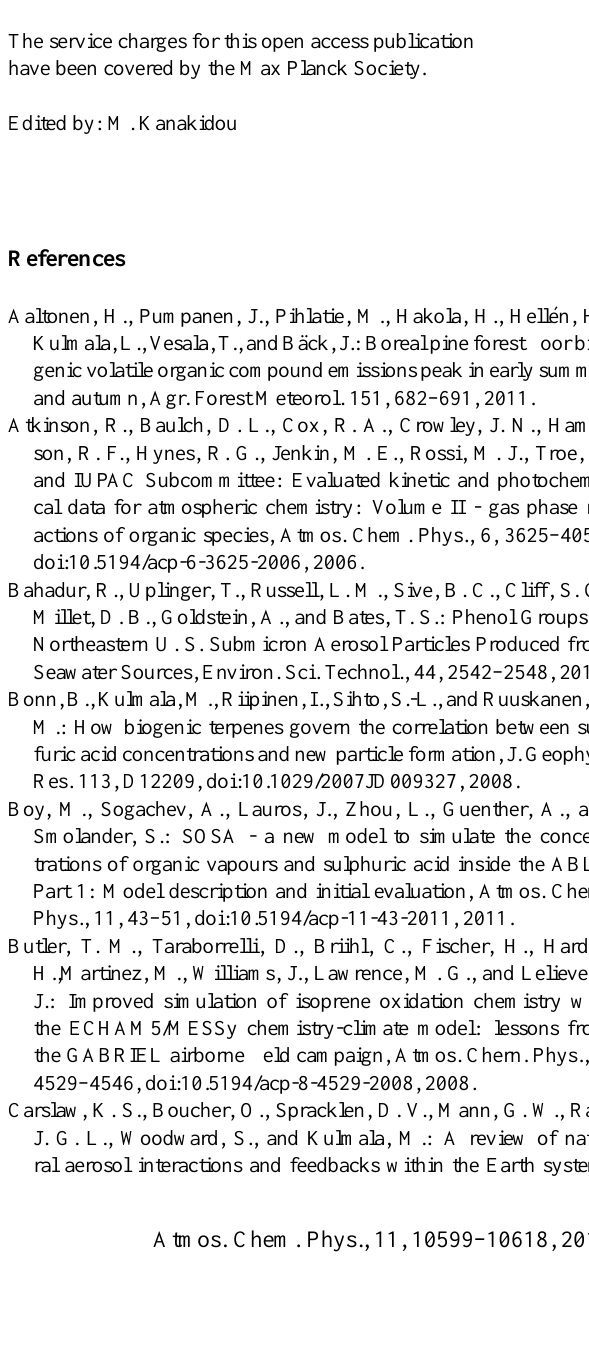
Fig. 10. Number concentrations of particles are plotted for the size range 3–25nm – (red) and 3–1000nm (black). Measurements taken from the main mast at